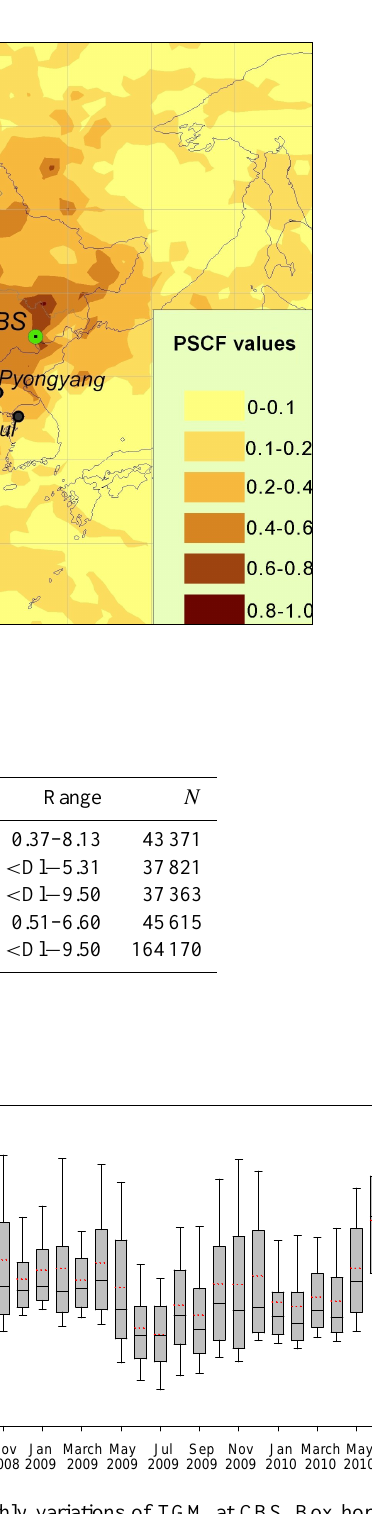
Fig. 8. Monthly variations of TGM at CBS. Box horizontal solid lines show 25th, 50th, and 75th percentiles, dotted line within each box indicates mean TGM concentration, and whiskers represent 10th and 90th percentiles of TGM